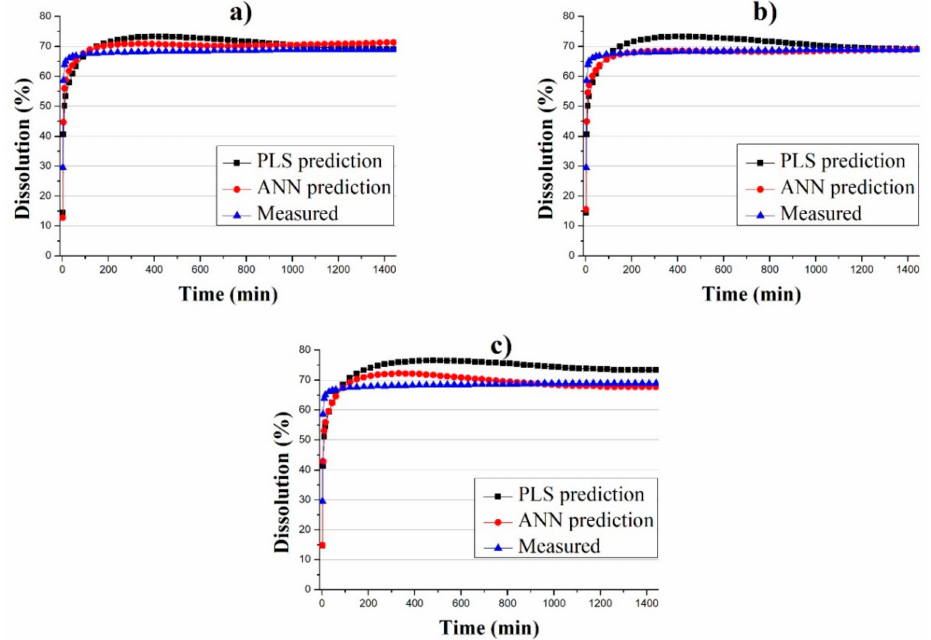
Figure 8. Average of predicted (PLS and ANN) and measured dissolution profiles of Formulation 1 tablets where predictions were based on ( a ) Raman, ( b ) NIR and ( c ) Raman and NIR